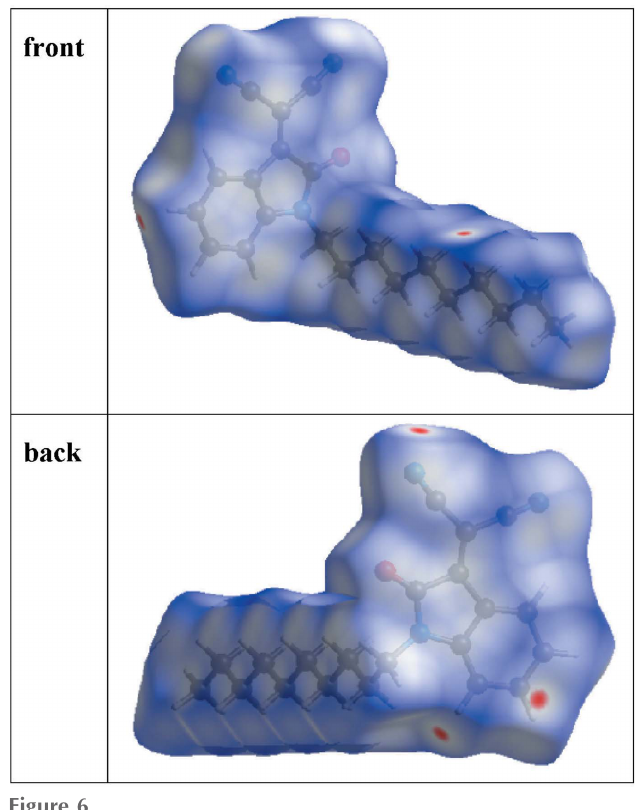
Figure 6 The d norm Hirshfeld surface of the title compound (red: negative, white: zero, blue: positive; scale: (cid:5) 0.0774 to 1.3395